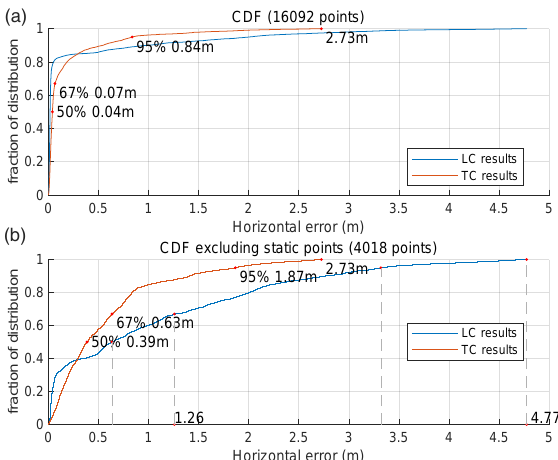
Figure 6: Track 1 CDFs of LC and TC integrated navigation results. (a) CDFs of all positioning results; (b) CDFs of only kinematic phase, static positioning points are excluded.